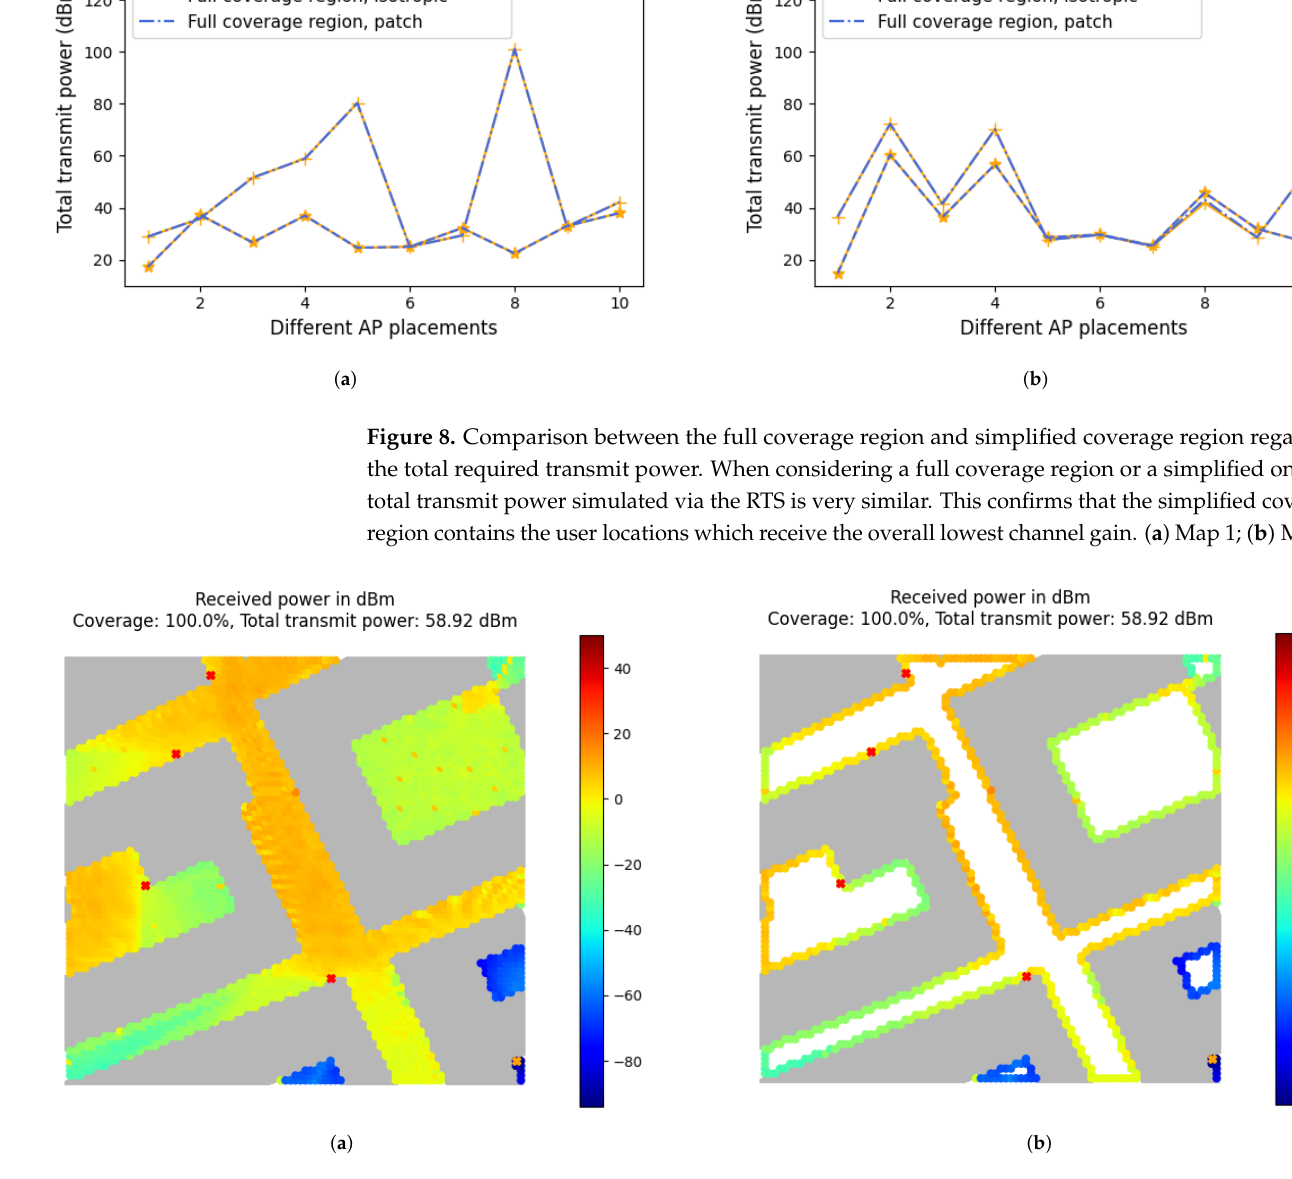
Figure 9. Comparison between the full coverage region and simplified coverage region regarding the heatmaps of the average received signal power at user locations. The red spots are the APs. The orange spots are the user locations that receive the overall lowest signal power. ( a ) Full; ( b )